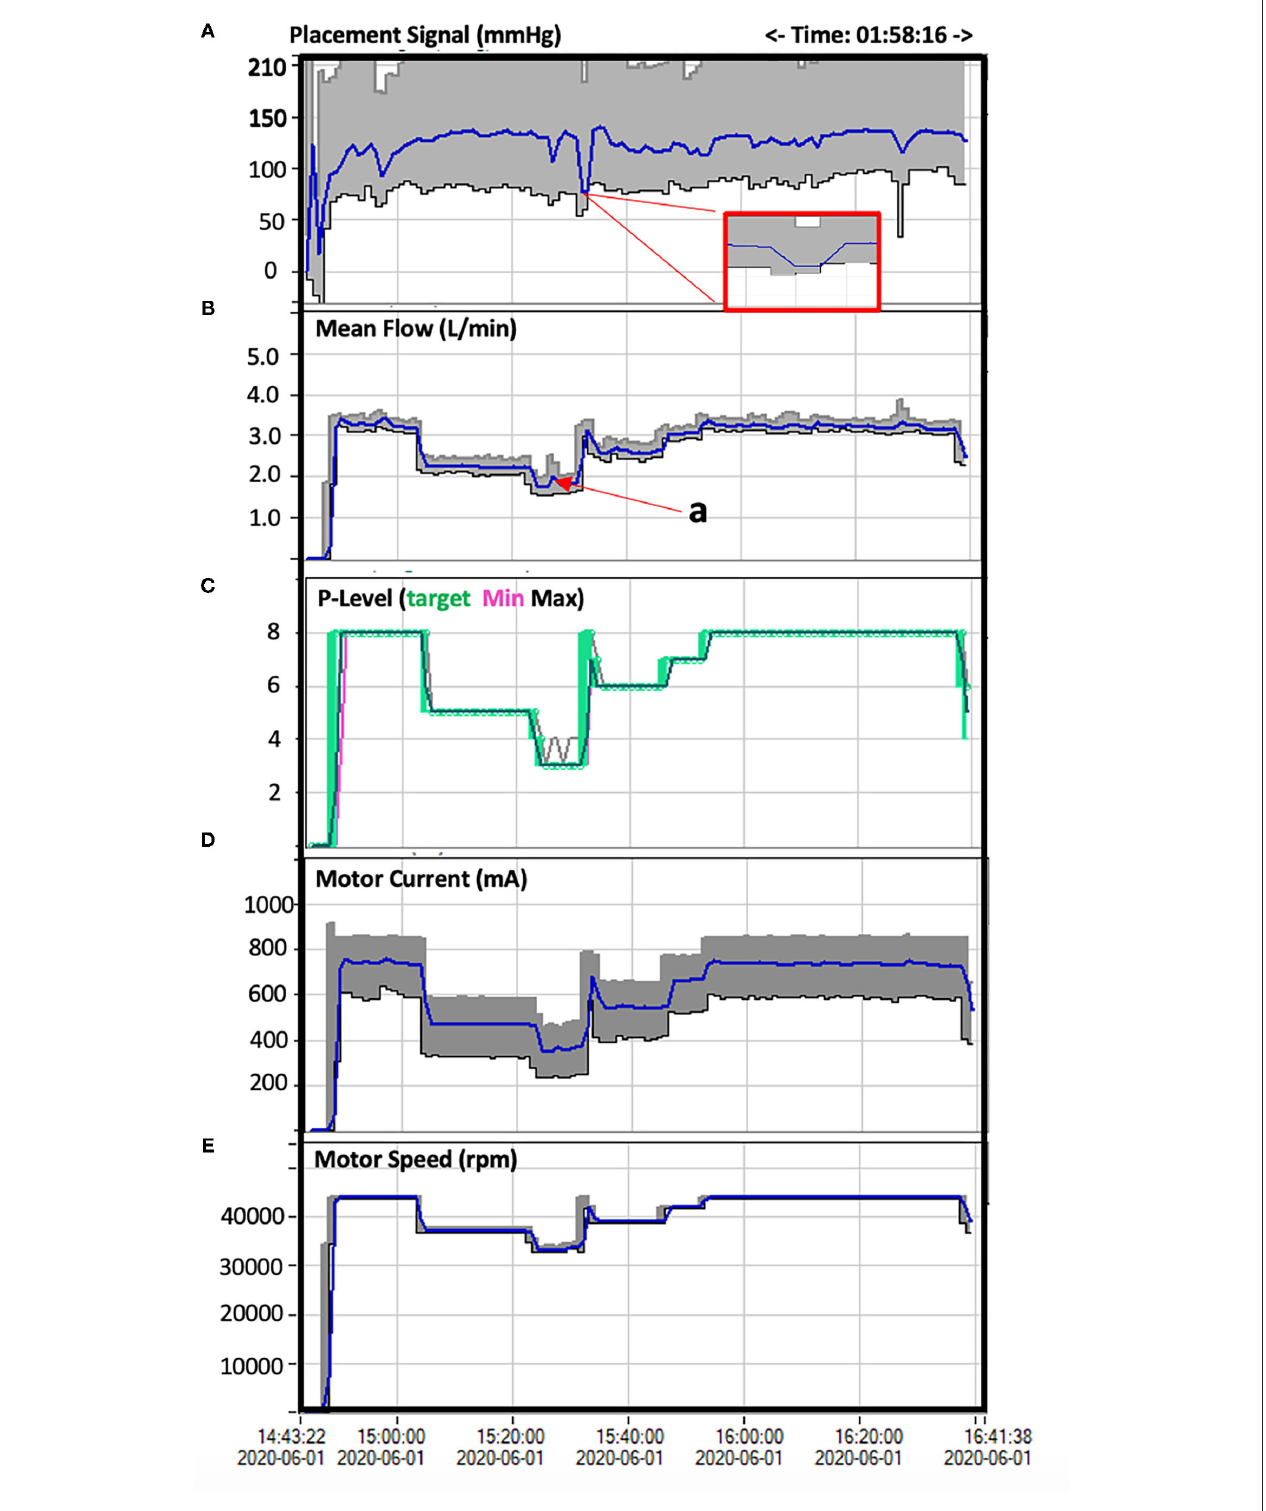
FIGURE 2 | Impella CP parameters during the procedure. (A) the Placement Signal is an approximation of the central aortic pressure (mmHg) with the gray area representing the systolic and diastolic pressures and the blue line the mean aortic pressure. The red box highlights in magnified form the 1-min pressure drop